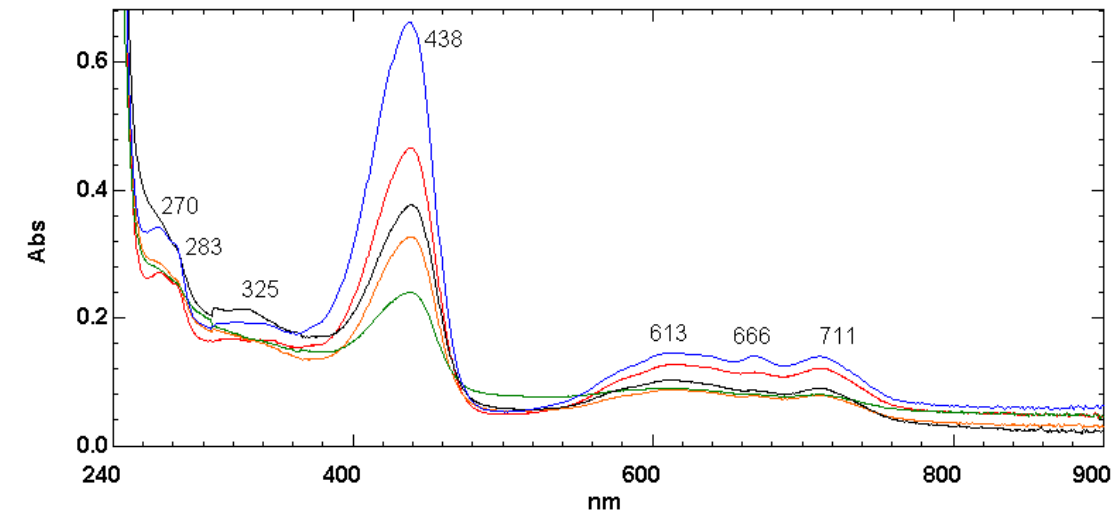
Figure 6. Electronic absorption spectra of PLLA green thin solid film (30 µ m thick) from used water bottles. The blue line represents the absorption curve of the pristine film, while the red, black, orange, and green lines were collected, respectively, after 3, 6, 10, and 66 days of exposure to ozone.